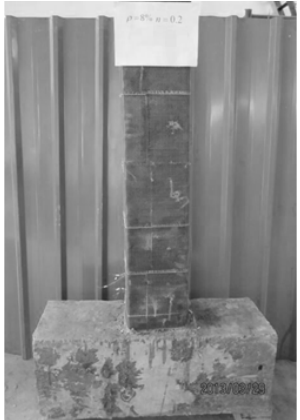
Figure 9. Z3 ( ρ = 8%, one layer).